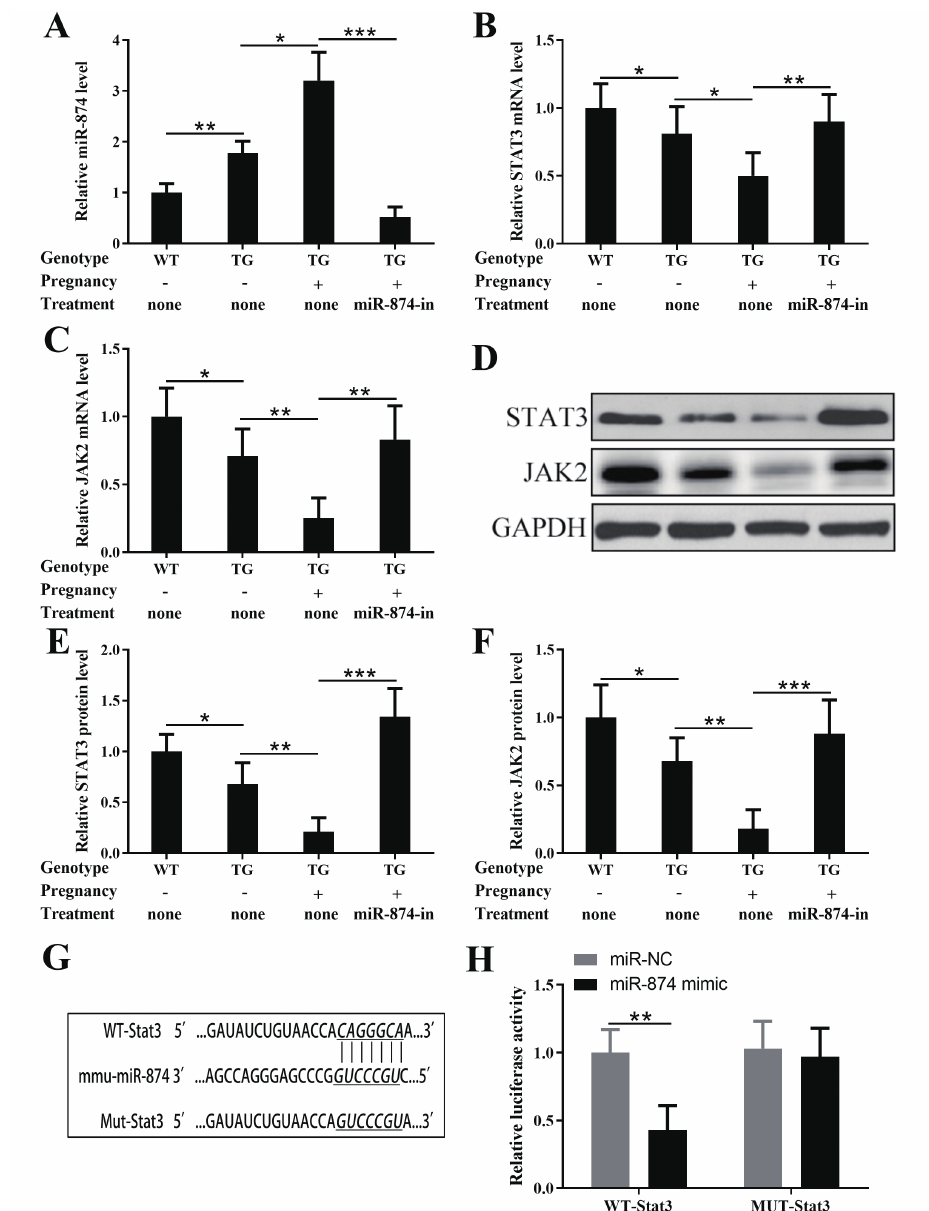
Figure 7. Inhibition of miR-874 targeted STAT3. QRT-PCR was used to measure the level of miR-874 (A), STAT3 (B) and JAK2 (C) among different groups. (D) Western blotting was used to measure the protein level of STAT3 and JAK2 among different groups and the relative expressions (E and F). (G) The suspected binding of miR-874 with the wild-type or mutant 3′-UTR region of STAT3 mRNA is shown. (H) Luciferase activity after the transfection of the wild-type or mutant 3′-UTR region of STAT3 along with miR-874 mimics. Age- matched, female non-pregnant wild-type (WT, n=18) and Gαq transgenic mice (GT, n=18), pregnant Gαq transgenic mice (n=8) and Gαq transgenic mice treated with miR-874 antagonist (miR-874-in, n=15) were compared. Data are presented as mean ± SD. *p < 0.05, **p < 0.01 and ***p < 0.001 between the indicated